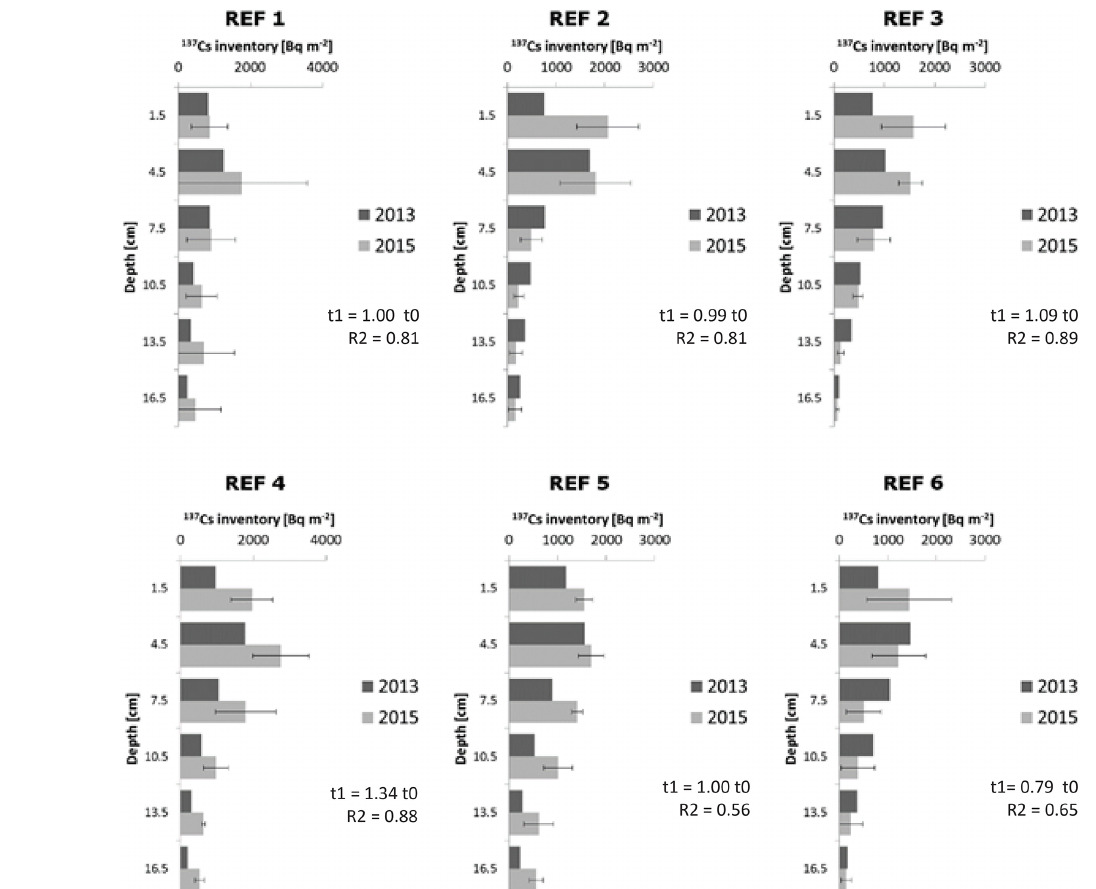
Figure 7. The 137 Cs depth profiles of the six investigated reference sites in the Urseren Valley for the two different sampling campaigns. The error bars indicate the standard deviations of the inventories among the replicates collected at each reference site 2015. The regression equation between the depth profile at t 0 and t 1 is displayed together with the R 2 .